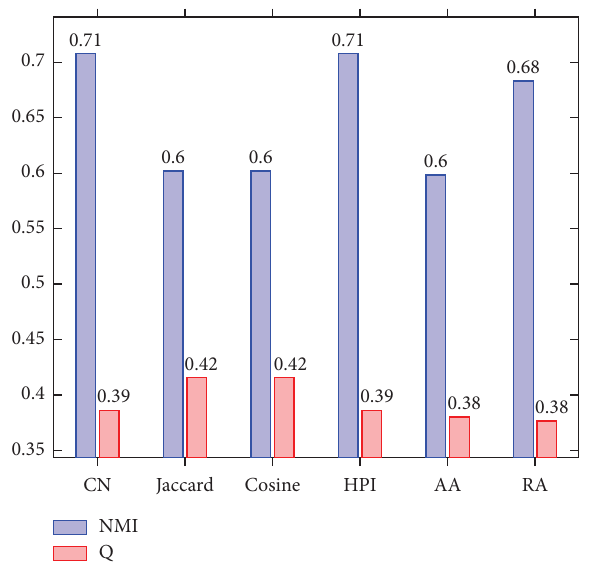
Figure 8: Comparison of the results of the proposed method for diferent similarity measures in the karate